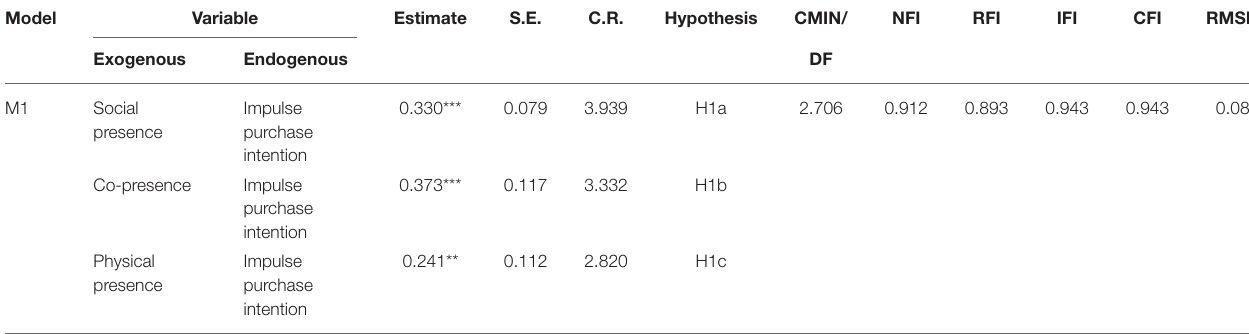
TABLE 7 | Results of main effect calculation and goodness of